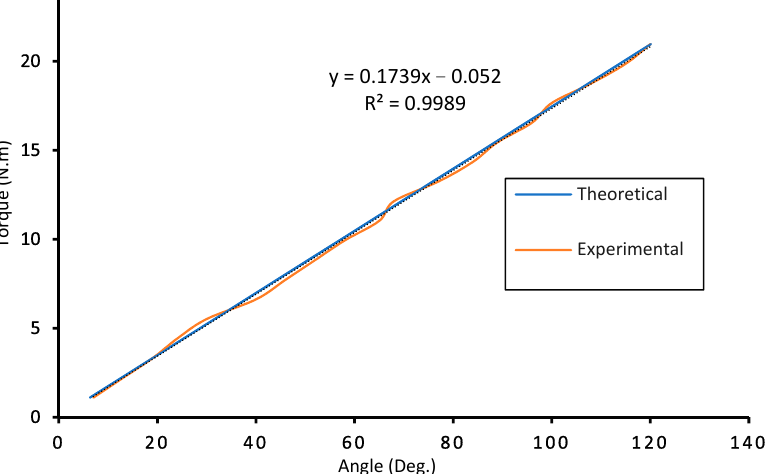
Figure 18. Characteristic of spiral spring stiffness the average experimental values and theoretical curves.